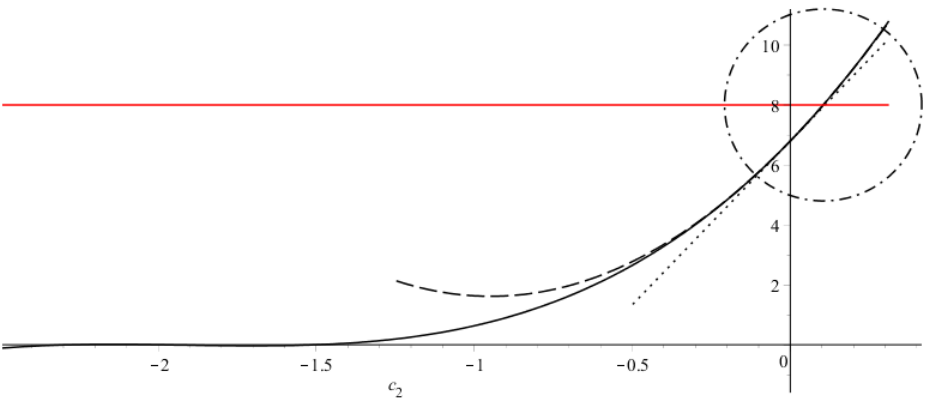
Figure A4. Solution to Equation (A7) (solid lines) and two its approximations in the c 2 ≥ 0 region giving c ∗ (dotted line) and c ∗∗ (dashed line). Parameters are the same as in Figure A2. Actual 2 2 differences between solutions are hardly distinguished at these parameter values, however at larger R v all differences increase (see Figure A5).